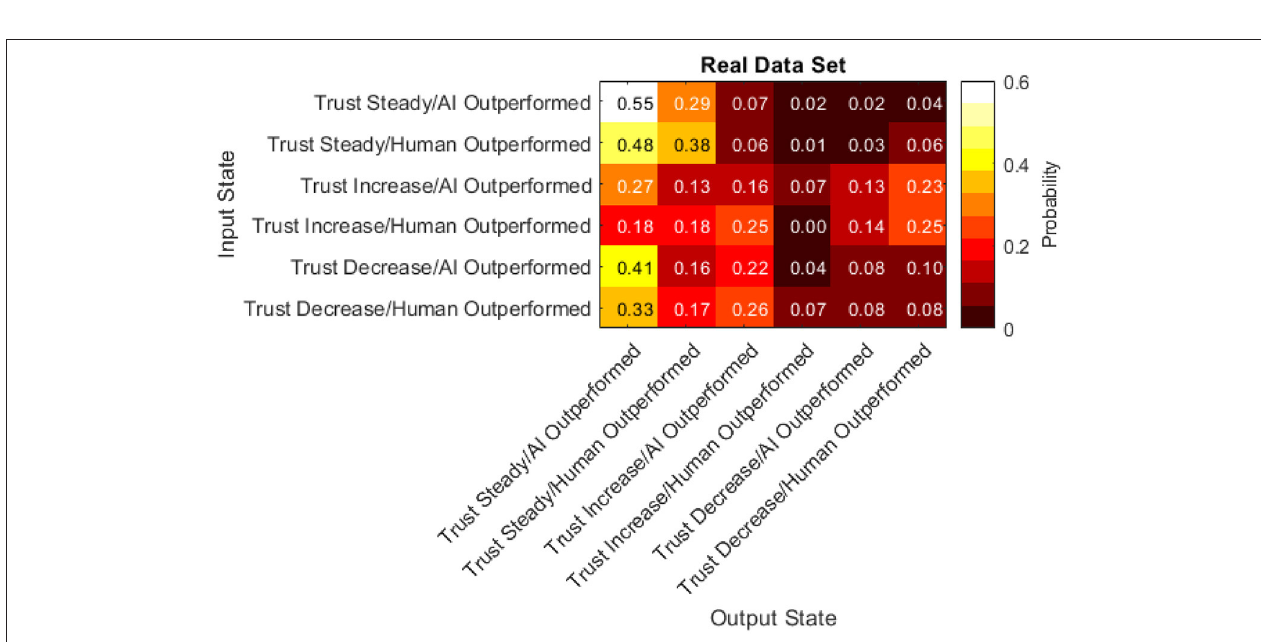
FIGURE 15 | Transition matrix of real data